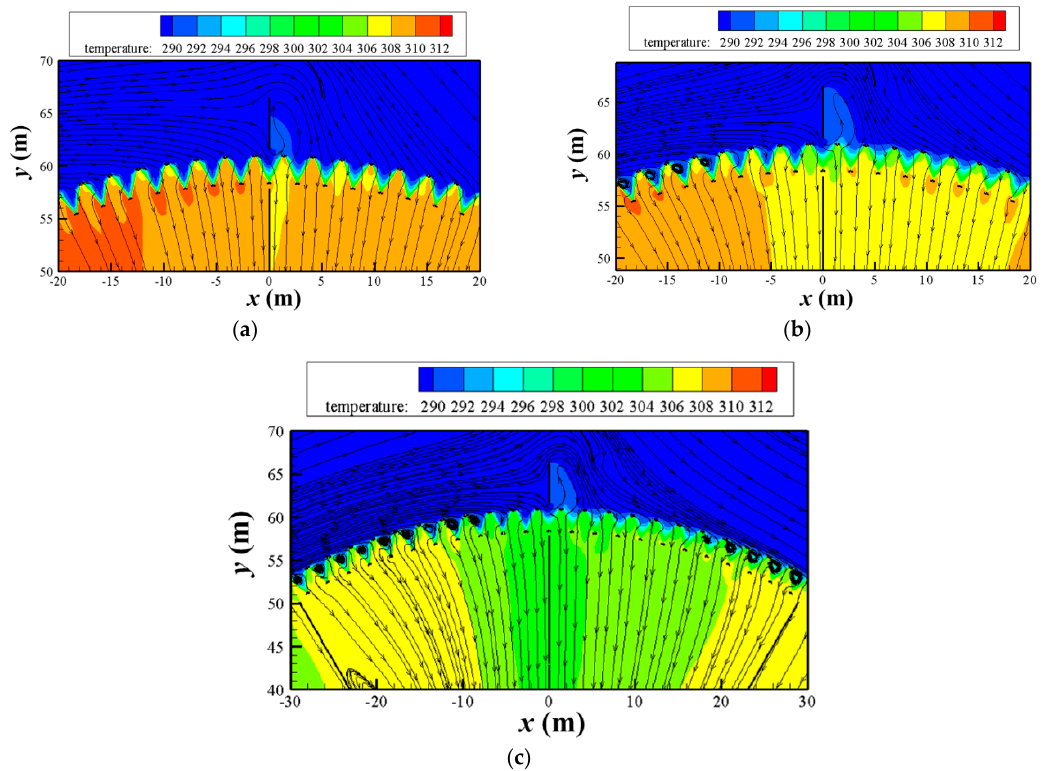
Figure 12. Flow and temperature fields through lateral cooling deltas of case D at various wind speeds. ( a ) at 4 m/s; ( b ) at 12 m/s; ( c ) at 20 m/s.